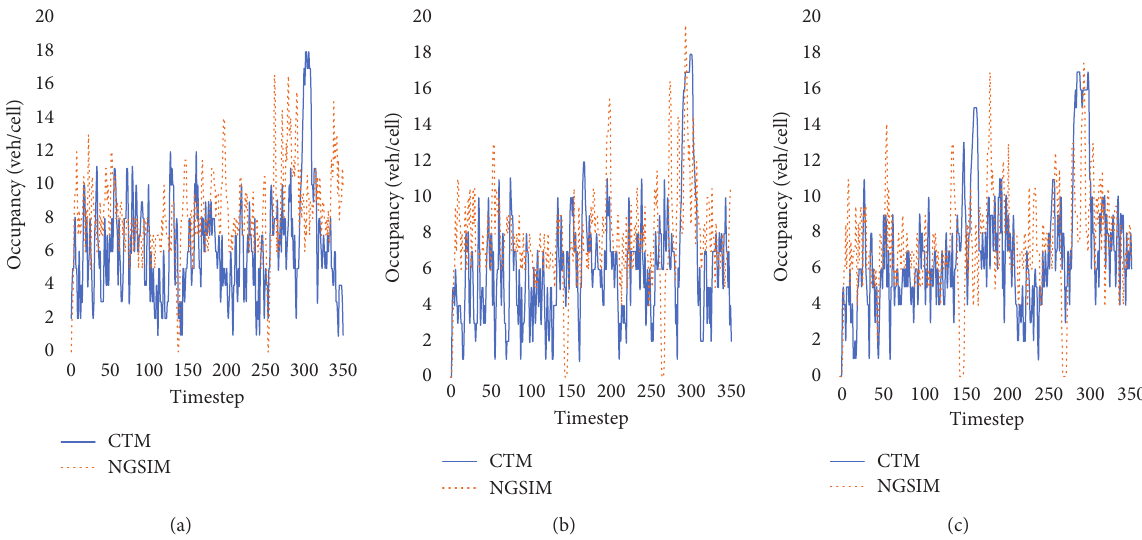
Figure 9: Case 4—comparison of the occupancies between CTM and US-101 in the specific cell: (a) C2L3, (b) C3L3, and (c)